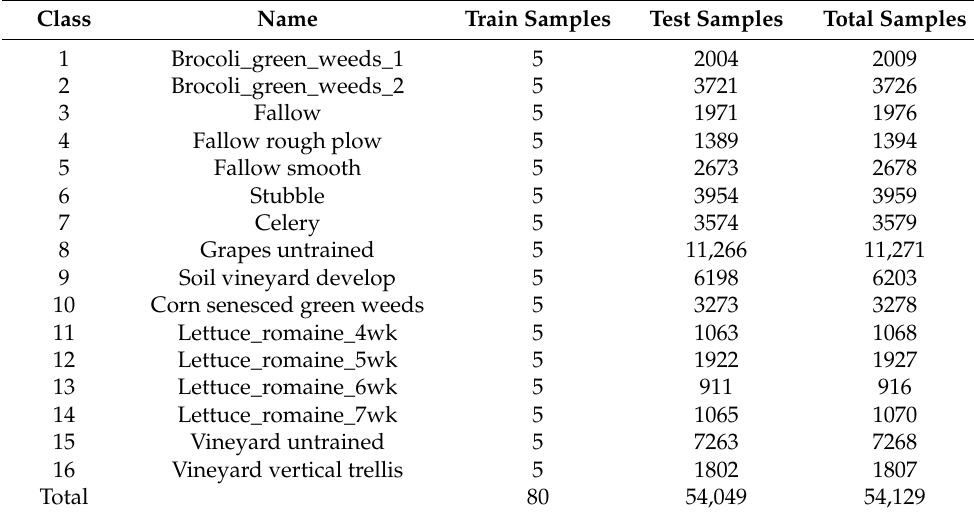
Table 3. The number of samples used for training and testing in the SA